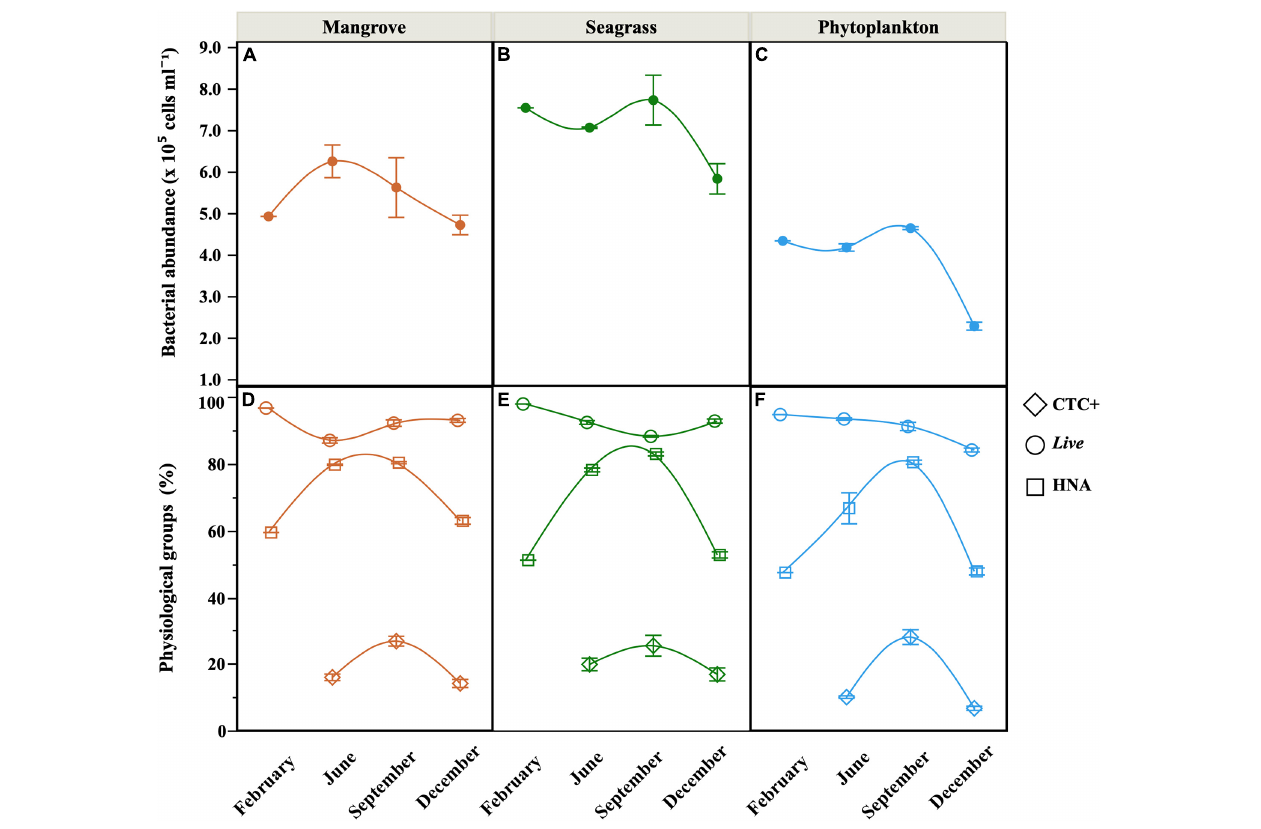
FIGURE 4 | Seasonal distribution of mean ( ± SE) values of total heterotrophic bacterial abundance (A–C) , sum of LNA and HNA cells) and the contribution of Live , HNA and CTC+ cells (D–F) at the onset of the incubations (unfiltered seawater, equivalent to the Community treatment) at the three sites. Smooth fitting joins site points for